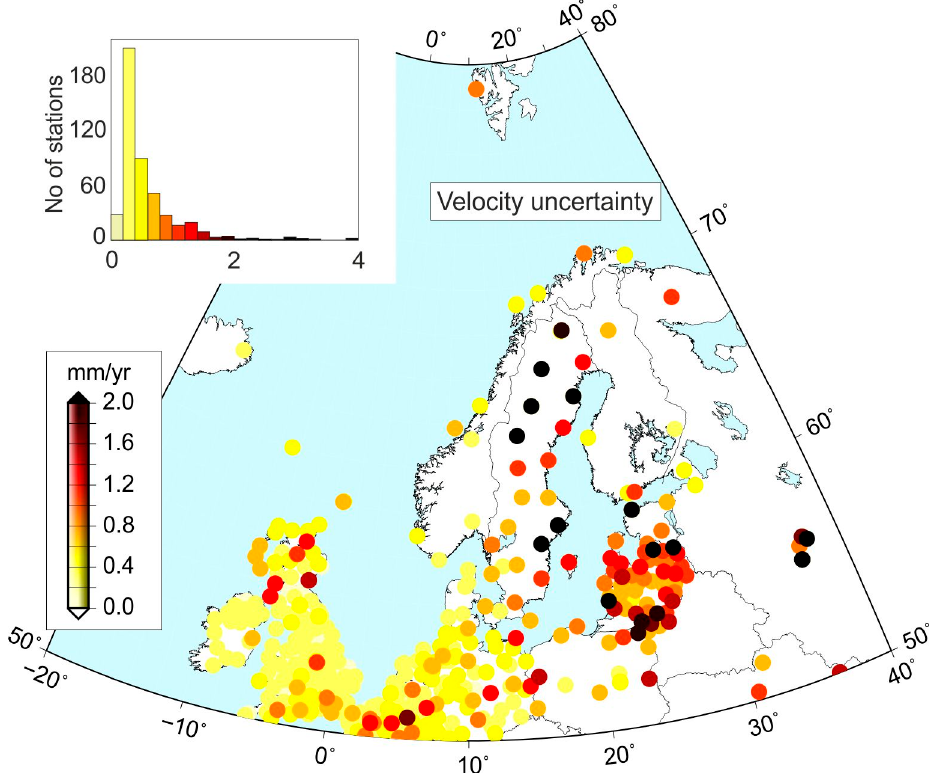
Figure 7. The uncertainties of vertical velocities for the 469 European GPS stations computed with the time series model from Equation (1), including the combination of power-law and white noise, as in Equation (3).